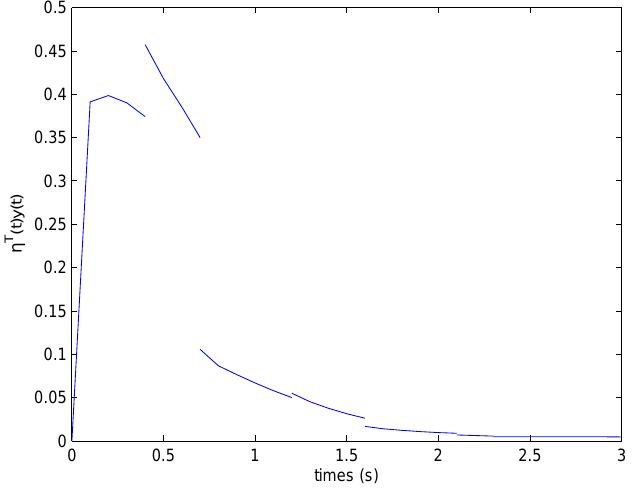
Figure 3. The output η T ( t ) y ( t )